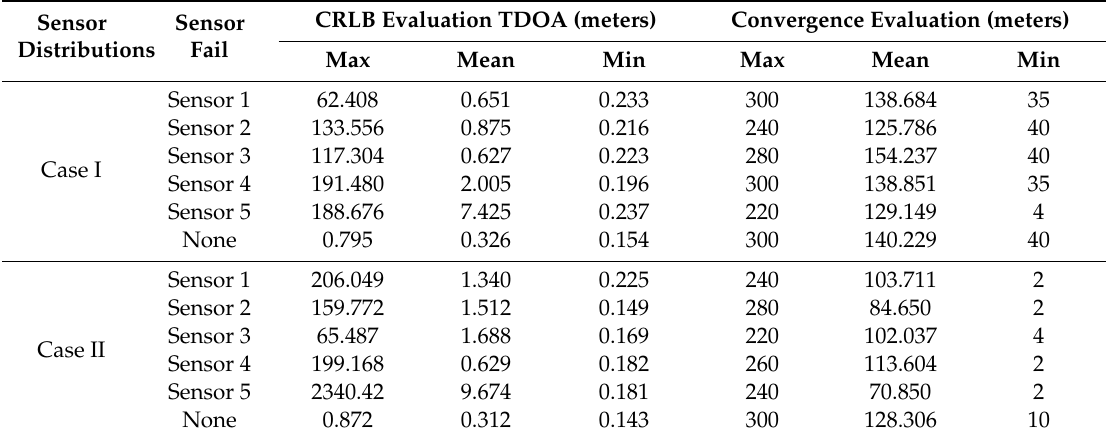
Table 4. Comparative between the optimizations of Case I and II.